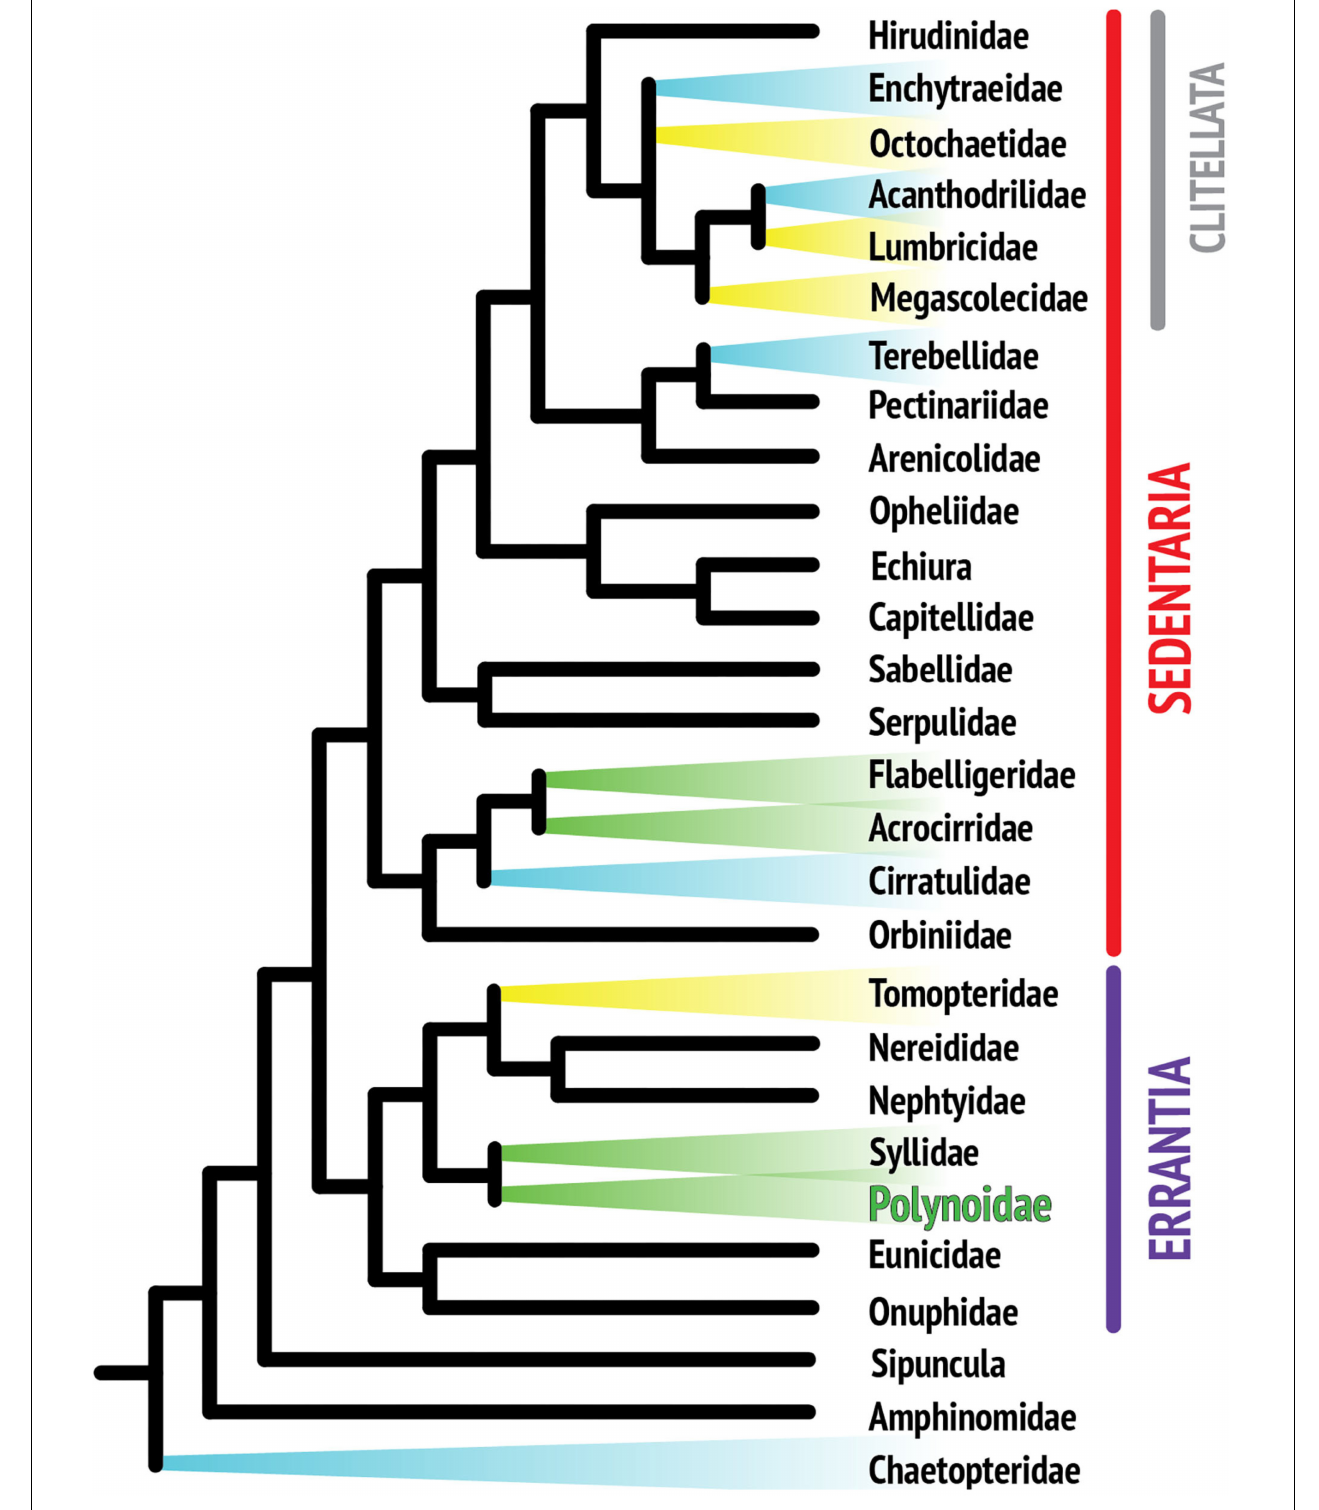
FIGURE 1 | Composite phylogenetic tree of annelid families based on recent phylogenetic and phylogenomic analyses. Note that not all annelid families are represented, as the position of many taxa still remains unresolved. The monophyletic class Clitellata is nested within the paraphyletic polychaetes. Branches highlighted in color indicate families with reported bioluminescent representatives. Colors are indicative of the general color emitted by species within that family.